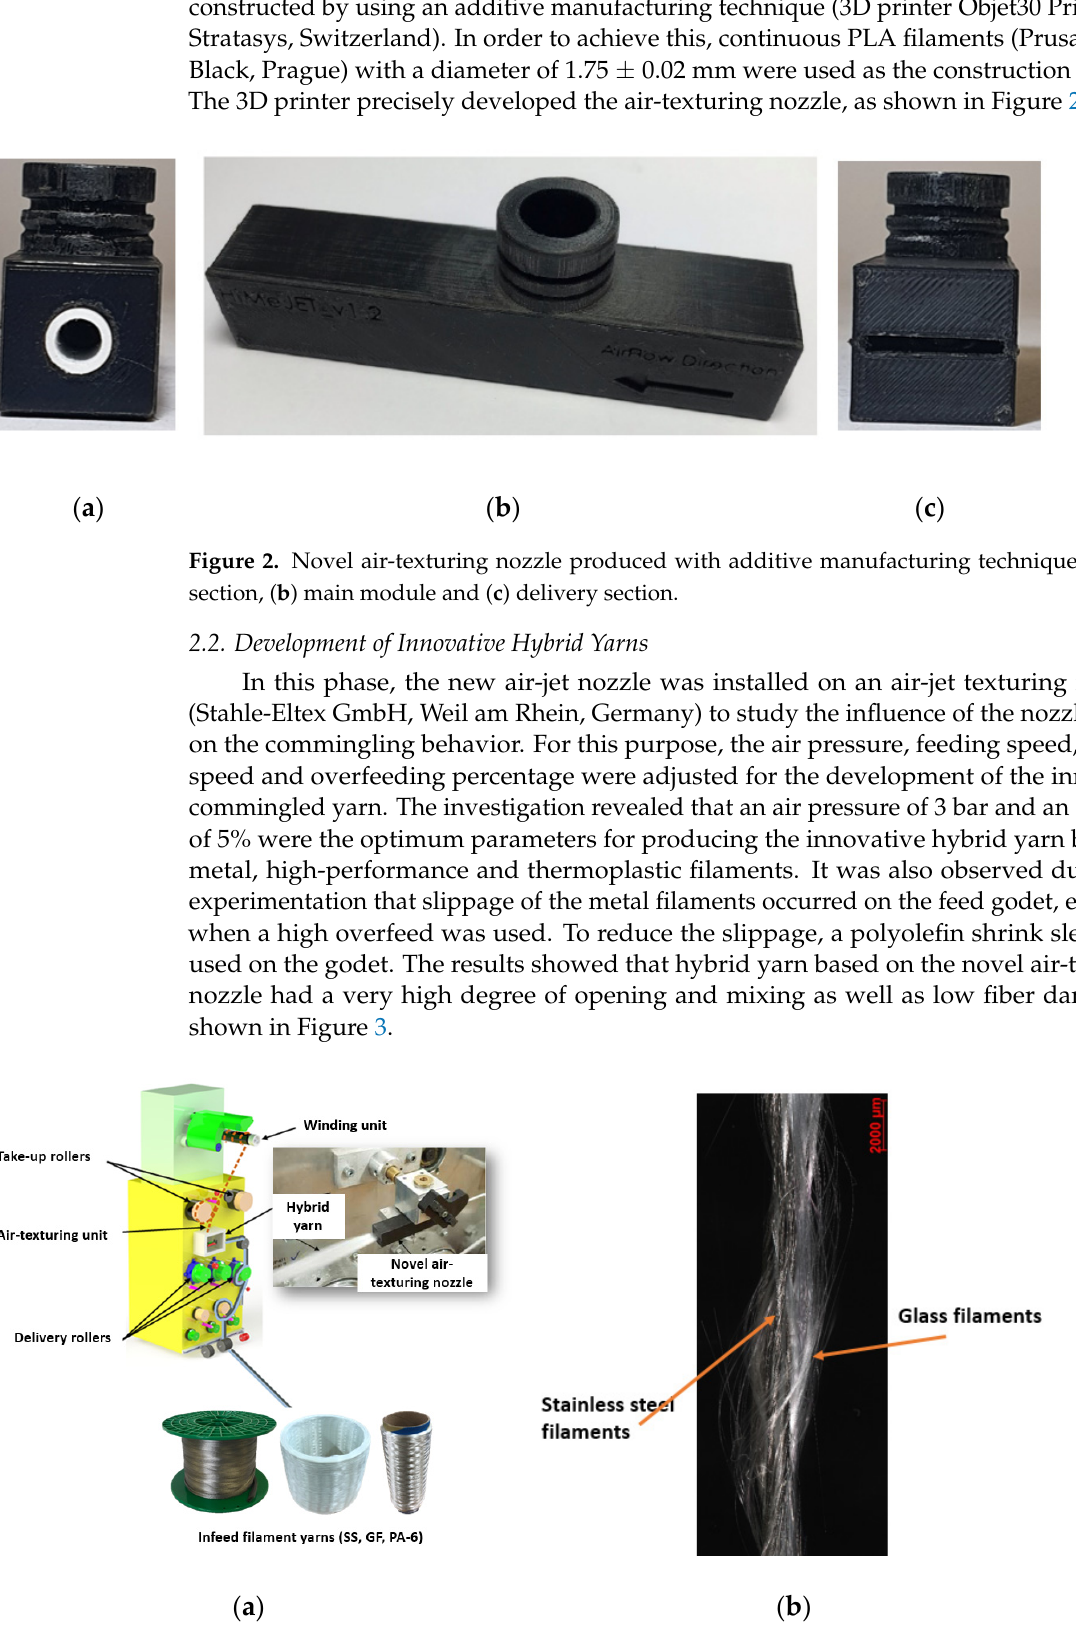
Figure 1. Optimized novel air-jet nozzle geometry with air flow profile.